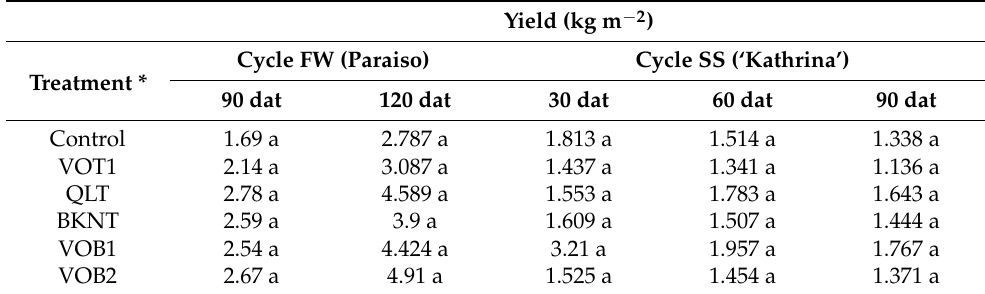
Table 10. Effect of treatments on third quality cucumber fruits during the FW and SS cycles. Yield (kg m − 2 ) Cycle FW (Paraiso) Cycle SS (‘Kathrina’) Treatment * 90 dat 120 dat 30